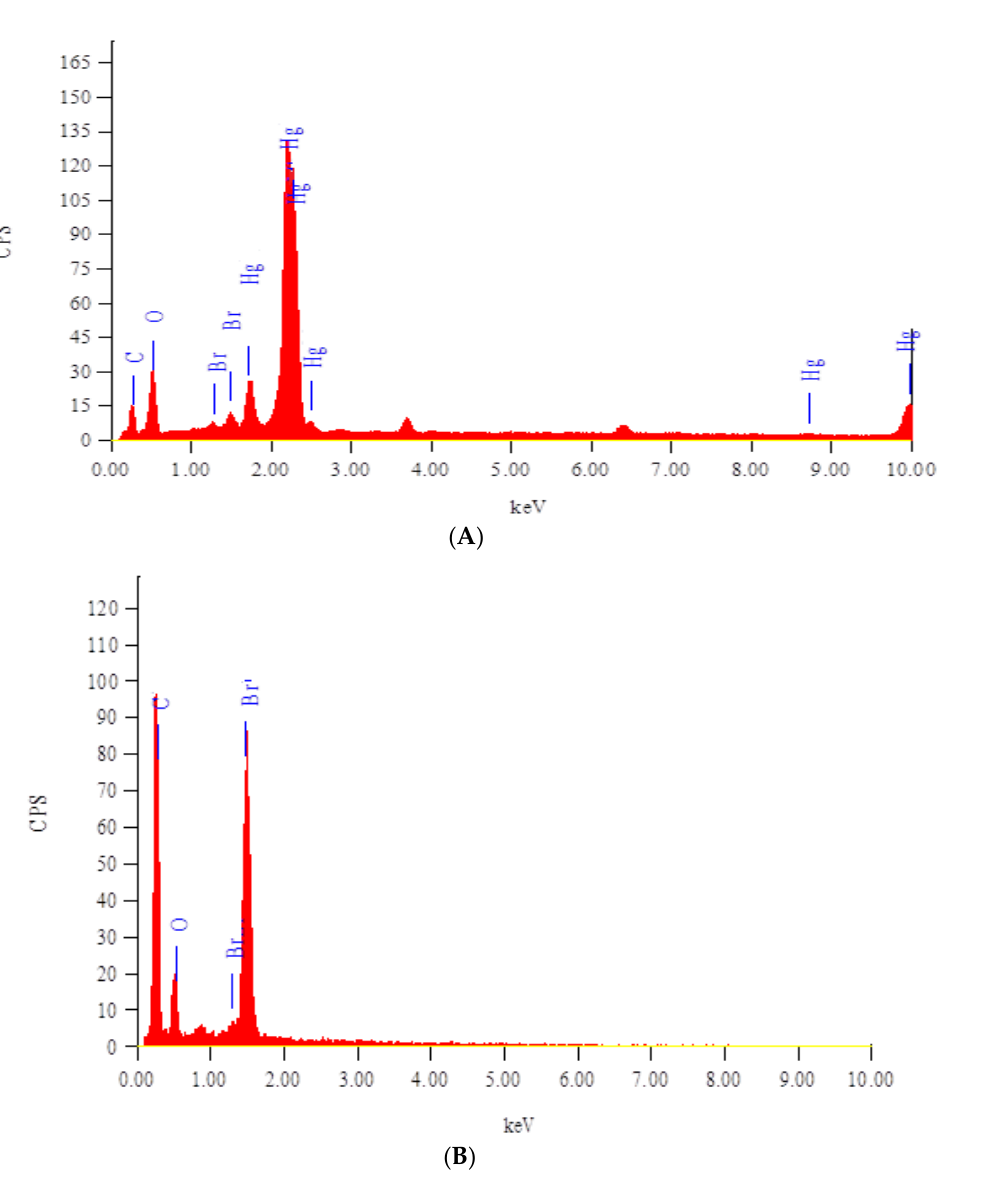
Figure 5. EDX spectra of ( A ) control membrane and ( B ) membrane selected for sensing mercury (II).